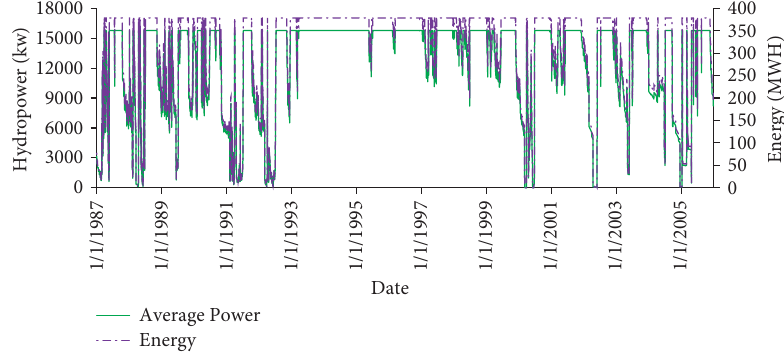
Figure 18: Average hydropower verses energy for base period scenario.